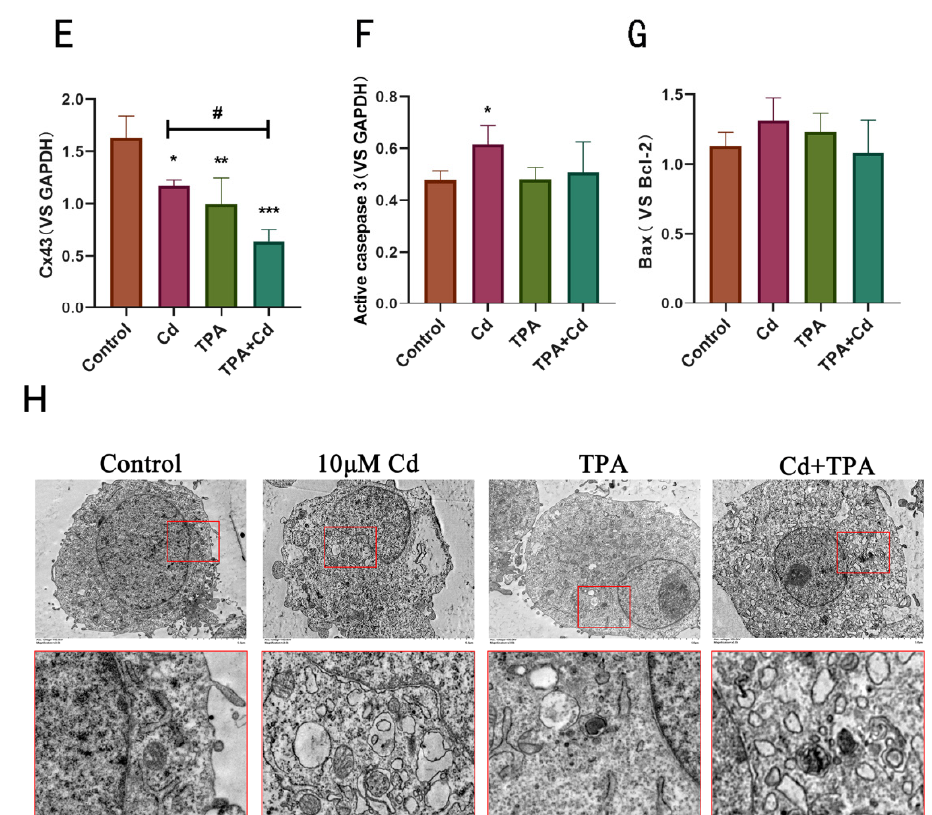
Figure 5. Application of TPA alleviated cell damage caused by Cd exposure in rat hepatocytes: ( A ) Light microscope observation revealed that co-treatment with TPA and Cd reduces cell death caused by Cd. Scale bar = 100 µ m; ( B ) TPA alleviates Cd-induced damage to the rat cell nuclei. Scale bar = 200 µ m; ( C ) CCK 8 assay results showing TPA alleviates Cd-induced reduction in the viability of rat hepatocytes, ** p < 0.01, vs. control; *** p < 0.001, vs. control; ## p < 0.01, vs. Cd; ( D – G ) Western blotting analysis of the levels of Cx43 and apoptotic proteins (activated-caspase 3, ratio of Bax to Bcl-2); * p < 0.05 compared to the control group; ** p < 0.01 compared to the control group; *** p < 0.001 compared to the control group; # p < 0.05 compared to the Cd group; ( H ) Observation of cell damage in rats treated with Cd and TPA by transmission electron microscope. Scale bar = 5 µ